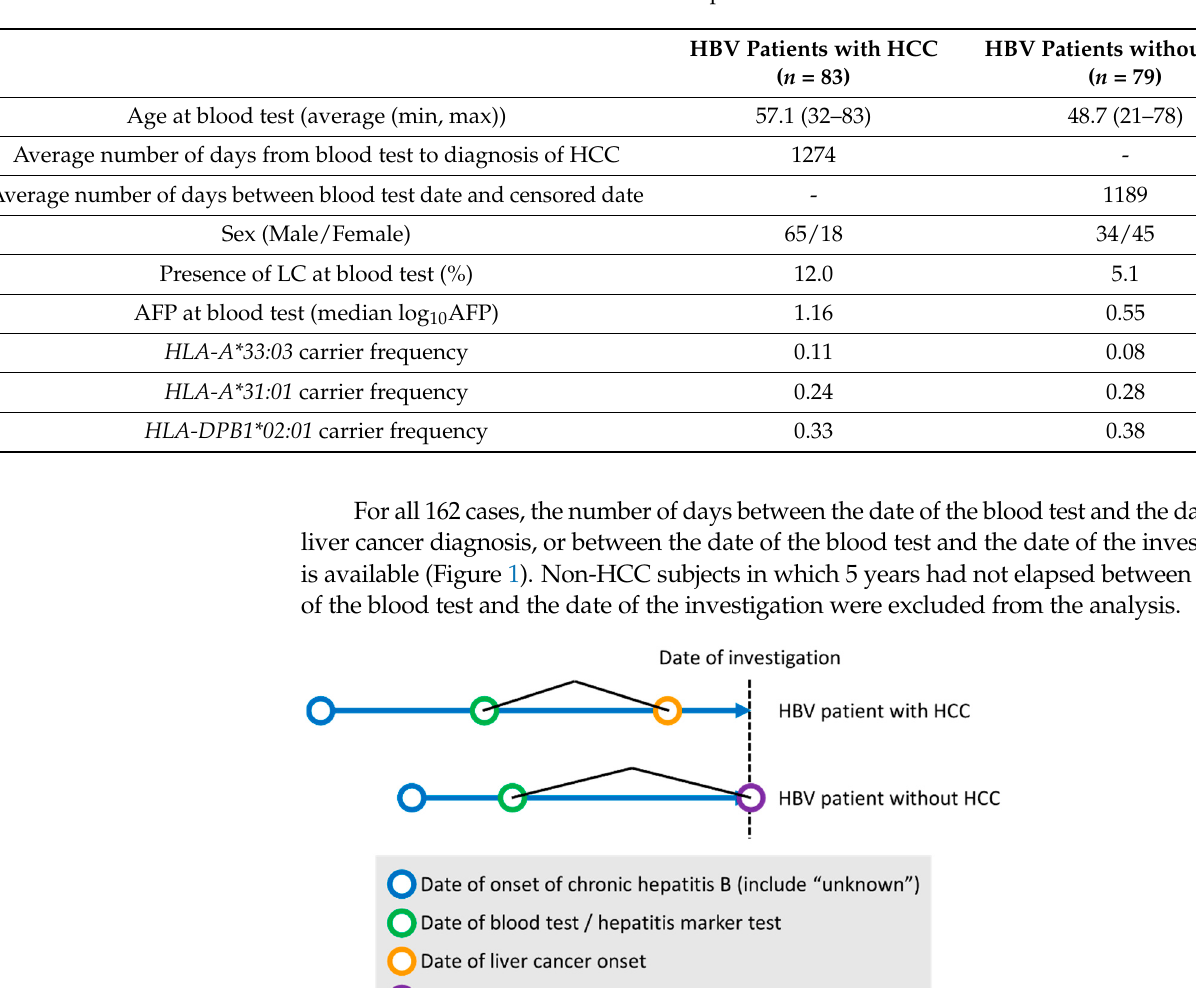
Table 1. Clinical information of 162 HBV patients without defects in 7 items.